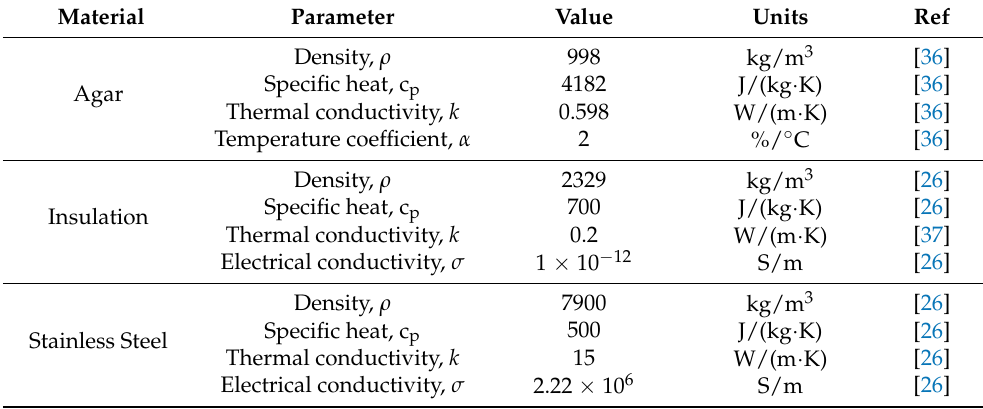
Table 1. Electrical and Thermal Properties for Computational Modeling.